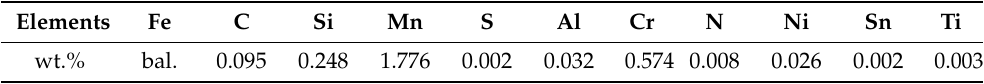
Table 1. Chemical composition of the low alloyed steel